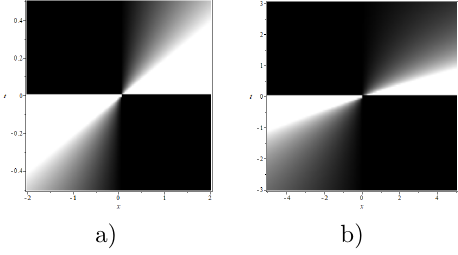
Figure 2. Analytical solutions of (3.5) are depicted, we select the parameter values: a) c 0 = 0 . 1 , σ = 0 . 0001, b) c 0 = 0 . 01 , σ = 0 .